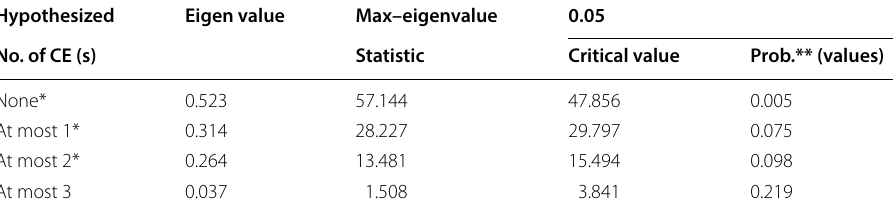
Max–eigenvalue test indicates 1 co-integrating eqn (s) at the 0.05 level *Denotes rejection of the hypothesis at the 0.05 level